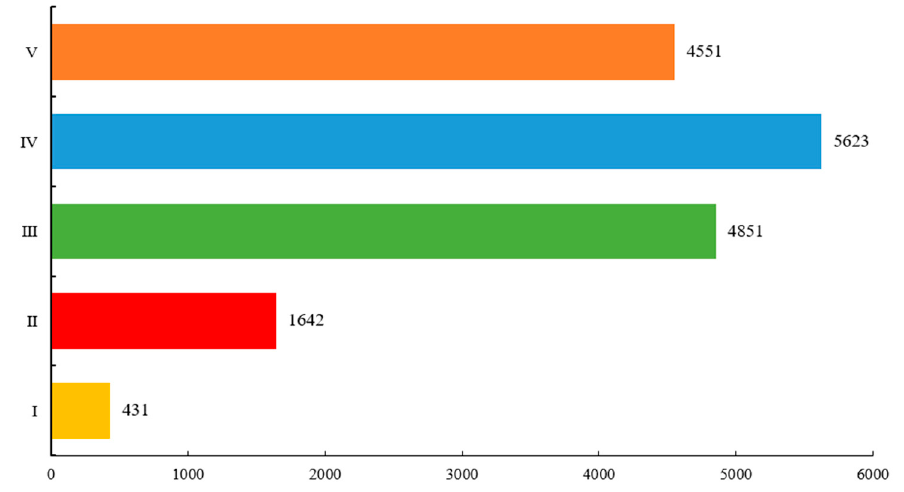
14 of 20 Table 3. Final clustering center temperature values. Indicators 26.82 Table 4. Clustering results of each pixel point. Sample Pixel Dots